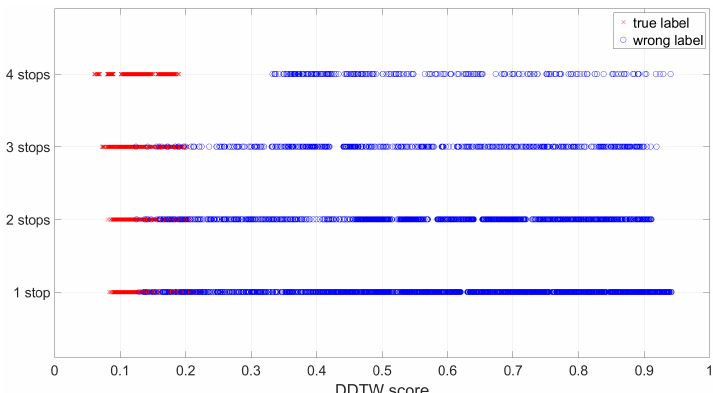
Figure 16. The distribution of the DDTW scores between all the test routes and the training routes: The longer the route is, the clearer the separation between the true co-located routes and the false non-co-located routes is.